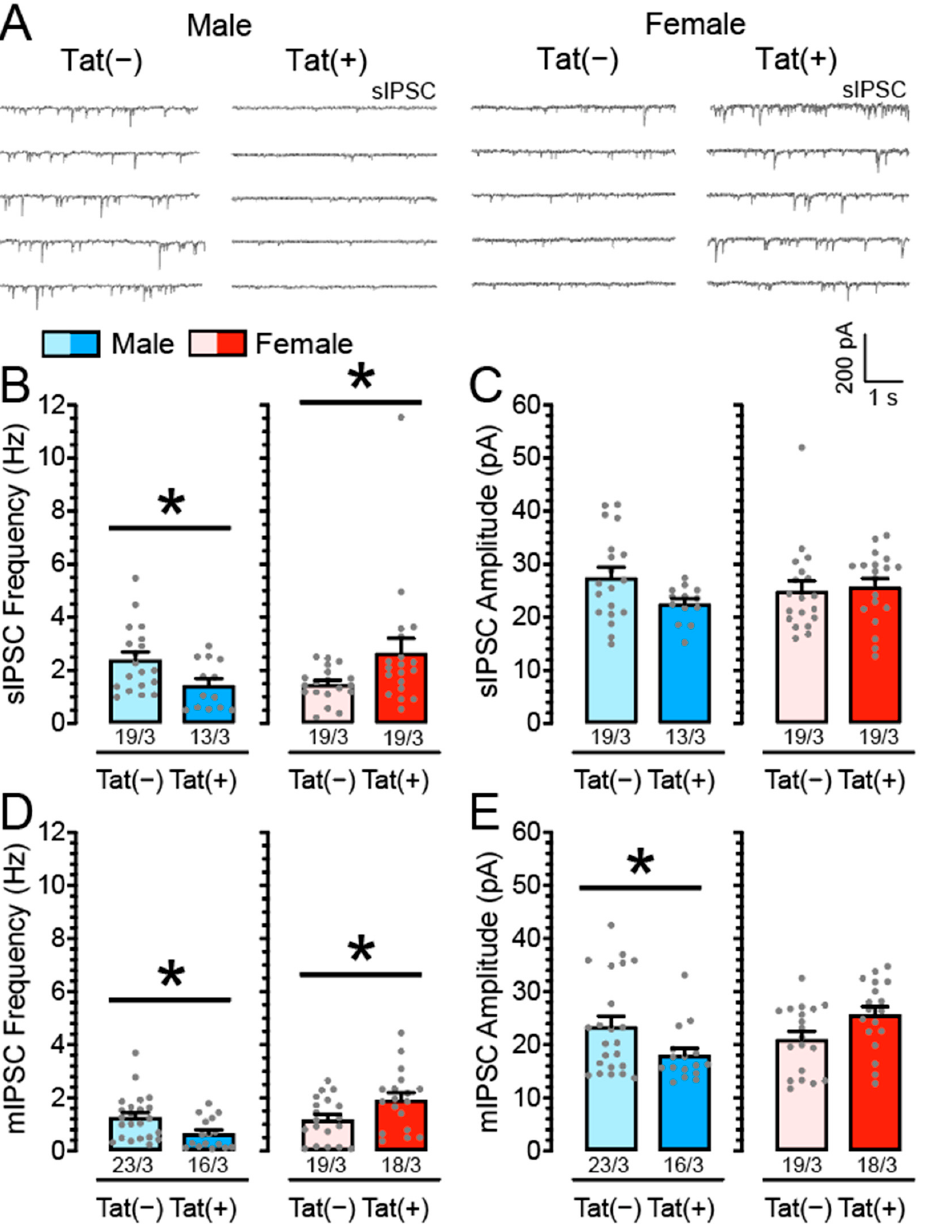
Figure 1. Tat induction alters the frequency and partially the amplitude of IPSCs in mPFC neurons in a sex-dependent manner. ( A ) Representative traces of sIPSCs in female and male Tat transgenic mPFC brain slices. ( B ) Tat induction significantly decreased mean sIPSC frequency for Tat(+) males compared to Tat( − ) males, whereas a significant increase in sIPSC frequency was demonstrated